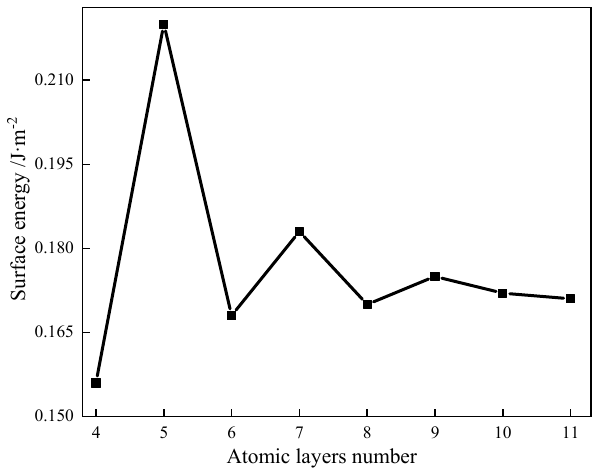
Figure 6. Relation of atomic layer number and surface energy of galena.